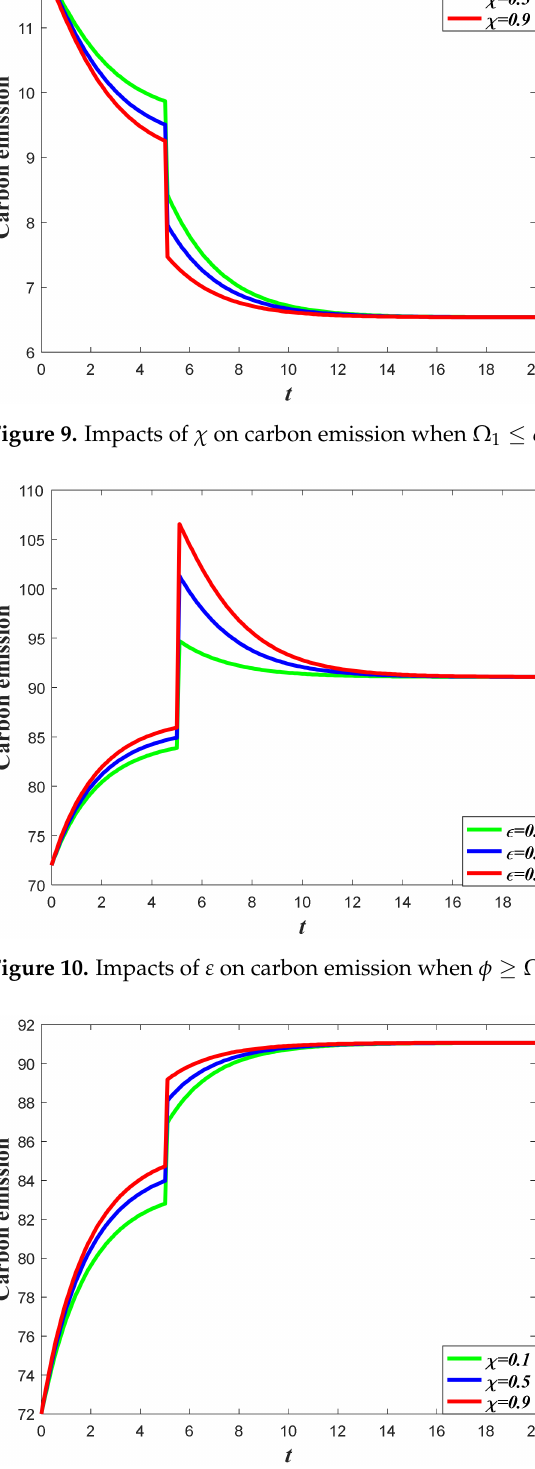
Figure 11. Impacts of χ on carbon emission when φ ≥ Ω 2